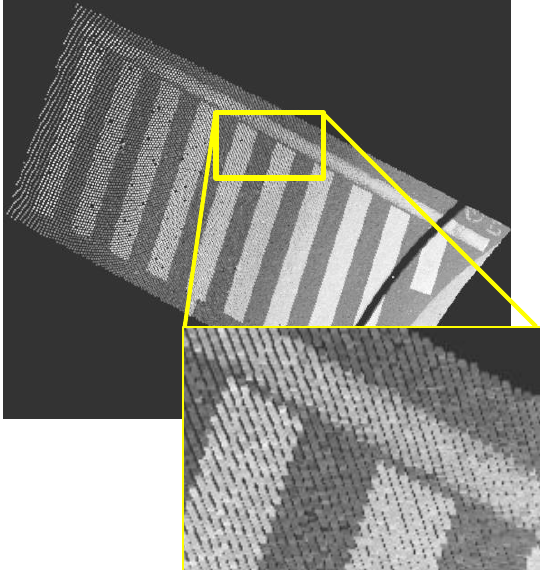
Figure 11. LiDAR data of traffic markings in processing area